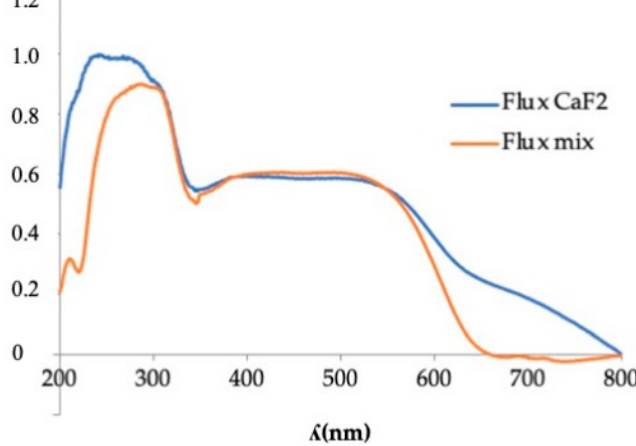
Figure 19. UV-Vis spectrophotometry of pigment Y 0.98 Al 0.98 Cr 0.04 O 3 fired with different flux